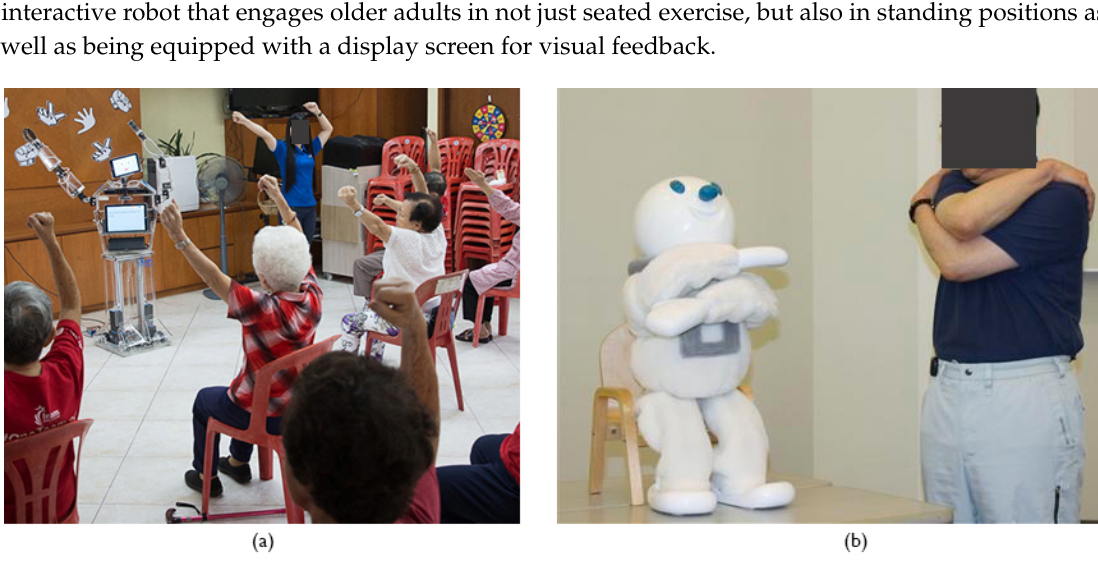
Figure 2. Social robots in action: ( a ) Robo Coach Xuan; and ( b ) Taizo